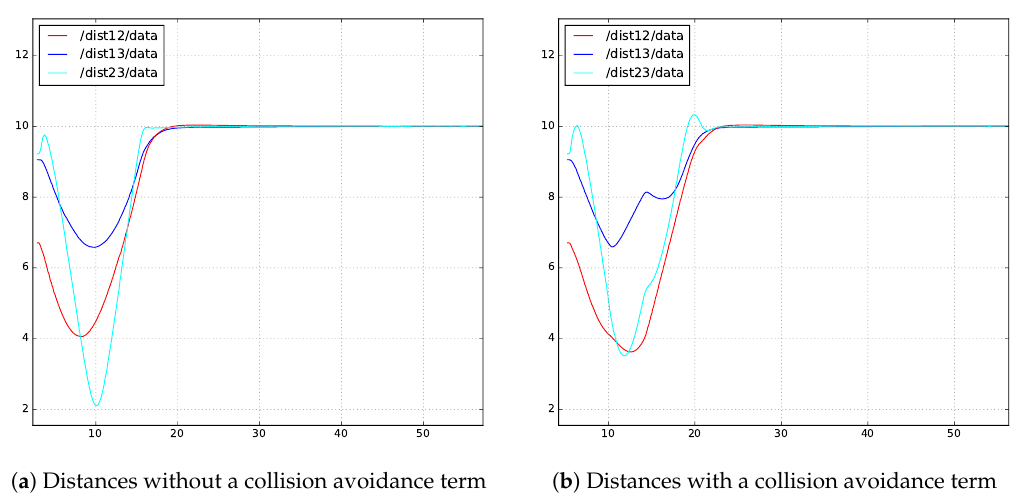
Figure 5. Distance among three BlueROV-1 in two experimental